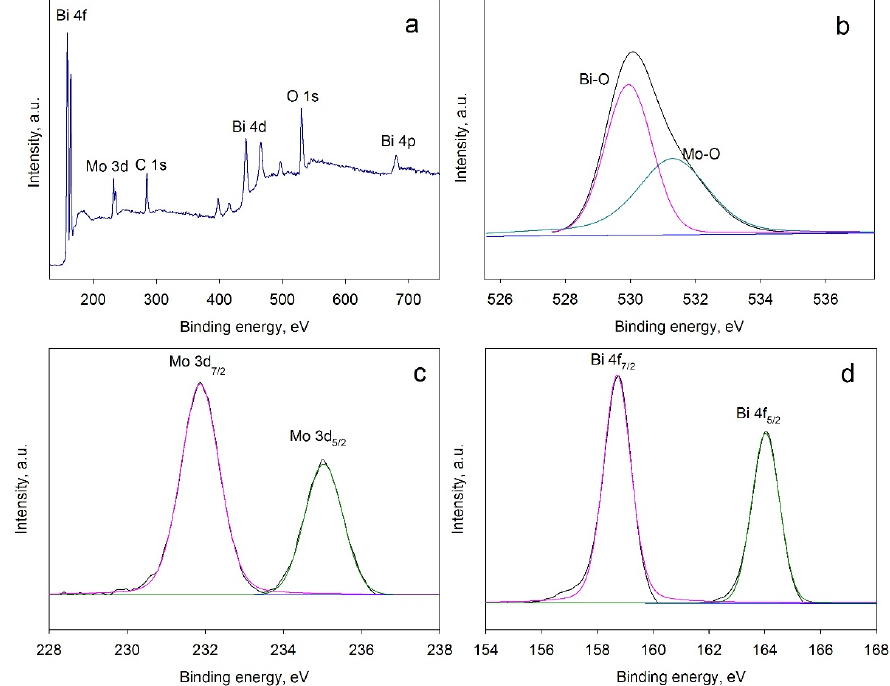
Figure 5. XPS results for coating BMO3: ( a ) Survey spectrum; ( b ) O 1s spectrum; ( c ) Mo 3d spectrum; ( d ) Bi 4f spectrum.